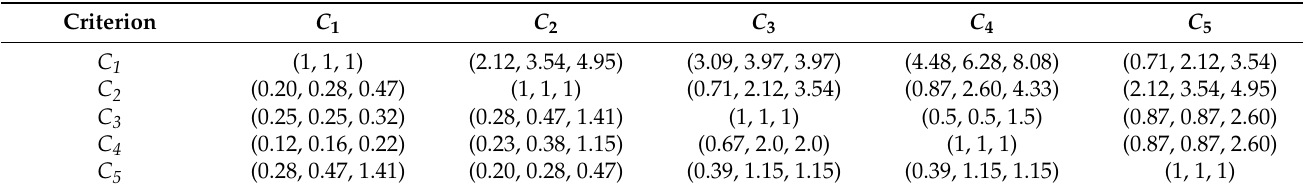
Table 3. The complete fuzzy comparison matrix for the defined